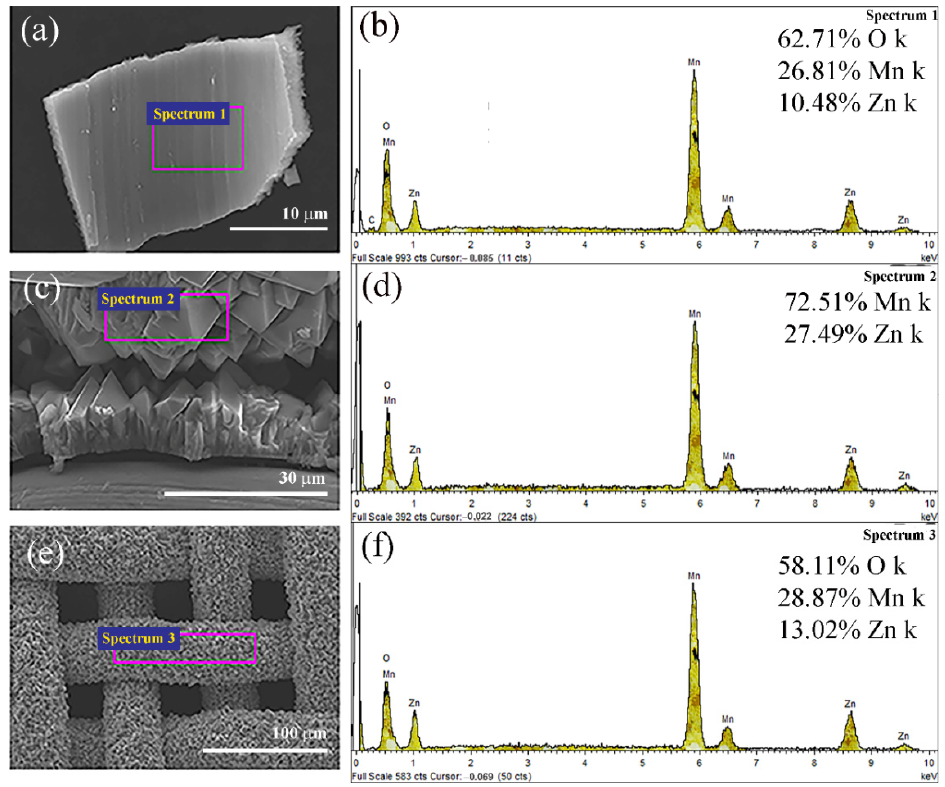
Figure 8. SEM-EDS elemental mapping of Zn, Mn, and O in ZnMn 2 O 4 samples prepared for ( a , b ) 6 h, ( c , d ) 12 h, and ( e , f ) 18